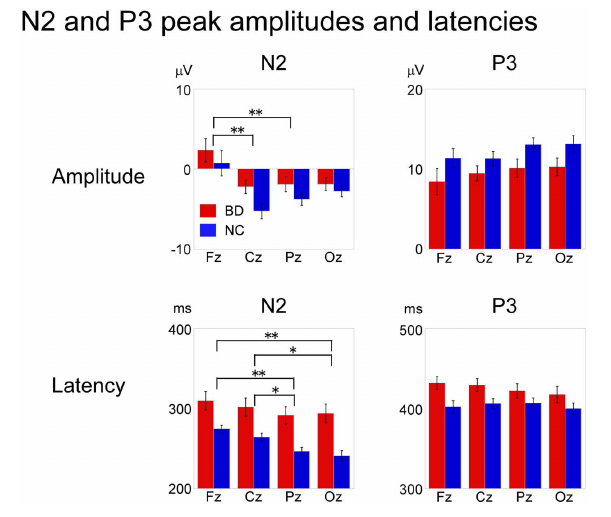
FIGURE 5 | Mean peak amplitudes and latencies of N2 and P3 at Fz, Cz, Pz, and Oz in BD and NC groups. N2 latency and P3 amplitude/latency were significantly different between the two groups. ANOVA revealed a significant main effect of electrode site for N2 amplitude and latency, whereas there were no significant statistical differences in P3 amplitude or latency among the electrode sites. Error bar: standard error of mean, ∗ P < 0 . 01; ∗∗ P < 0 . 001.